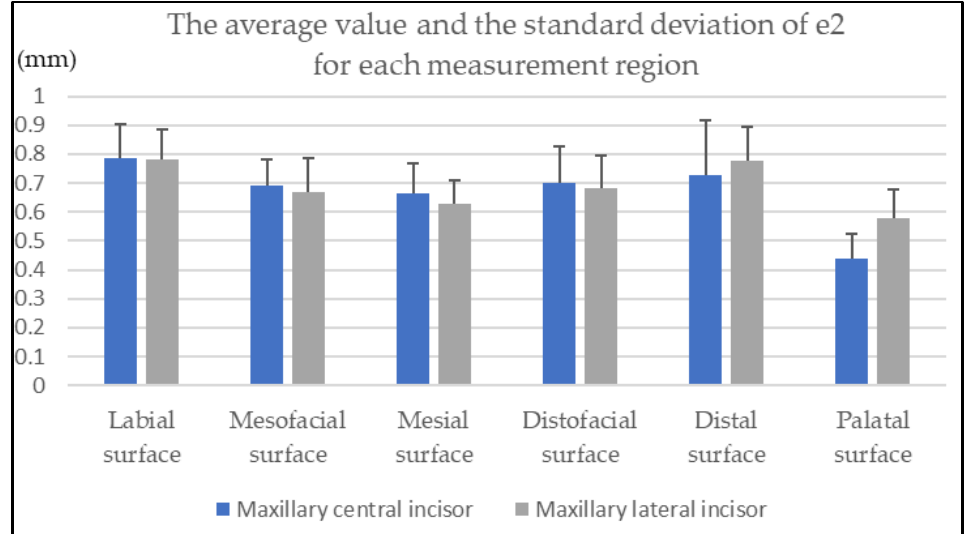
valid measurement sites for each measurement region.